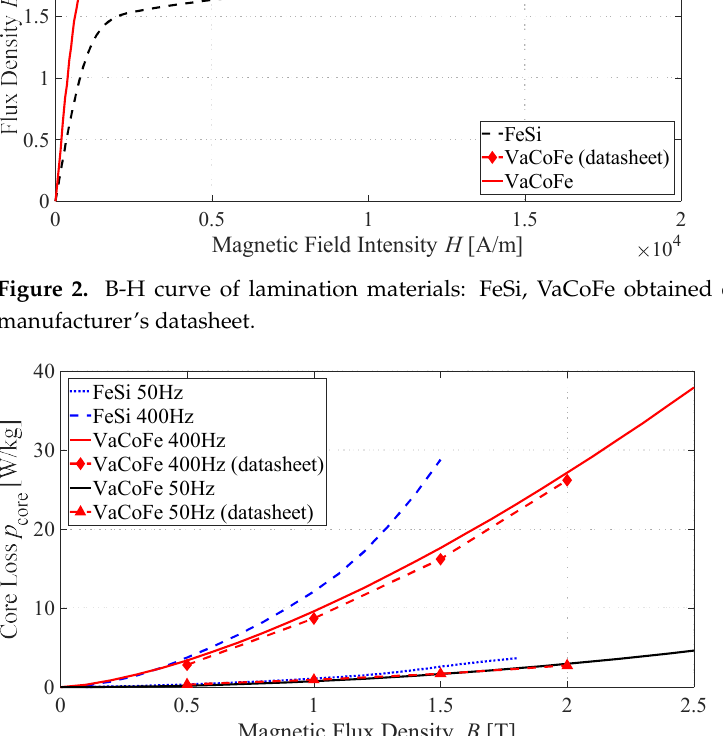
Figure 3. Specific losses curve of lamination materials: FeSi, VaCoFe obtained experimentally and from manufacturer’s datasheet, at 50 Hz and 400 Hz.